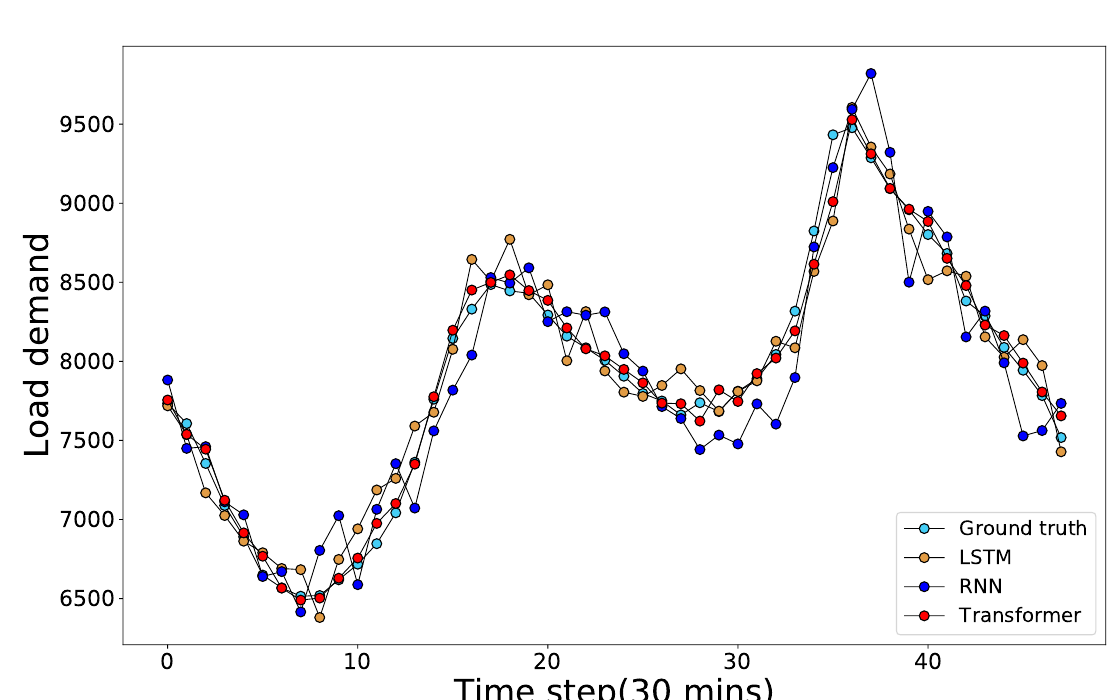
Figure 13. Mainstream algorithms day-ahead prediction performance comparsion (date 12 September